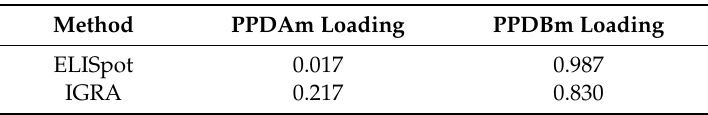
Table 10. Standardised loadings of PPDAm and PPDBm in the primary discriminant from a linear discriminant analysis between treatment groups in VES9 and VES10 (Stata 15 ‘candisc’